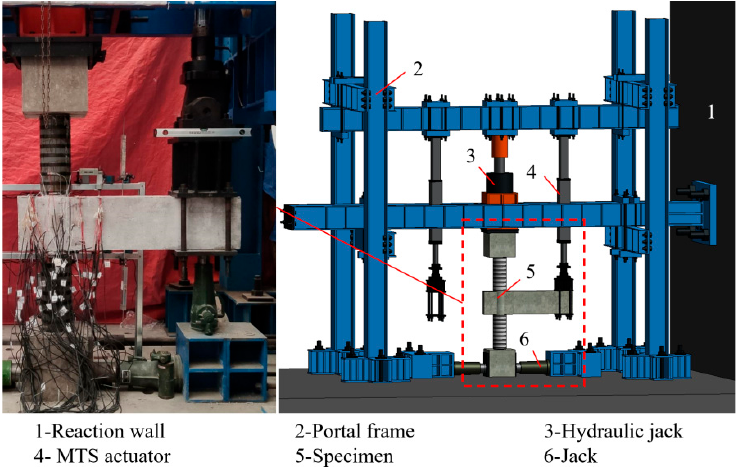
Figure 2. The loading and measurement